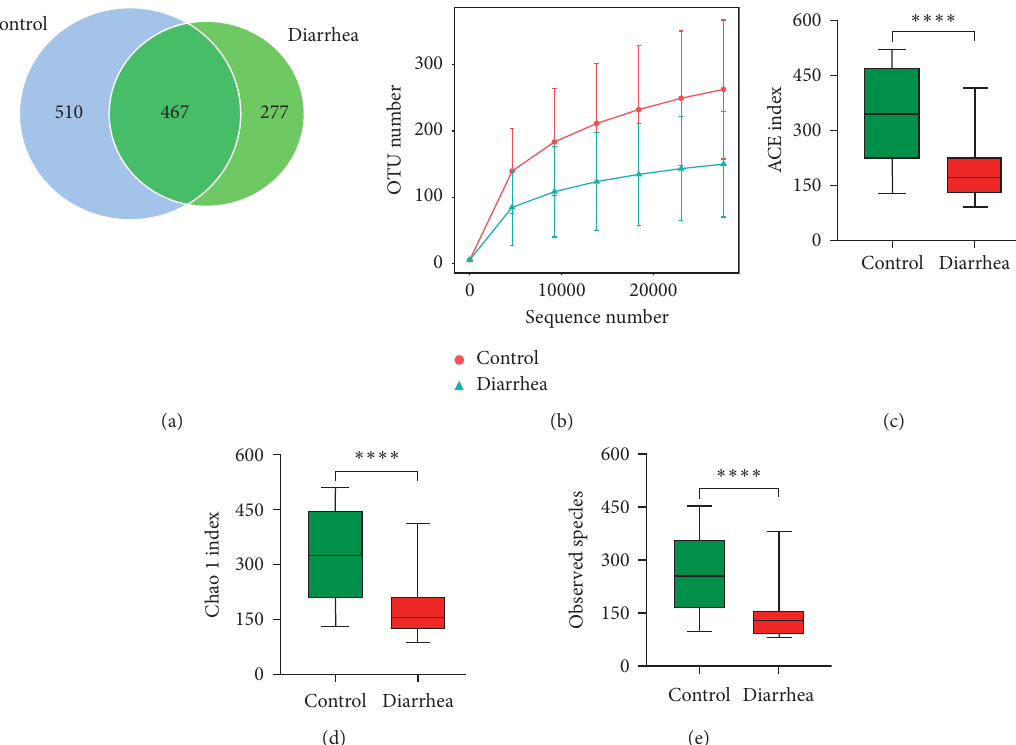
Figure 2: The alpha diversity of gut microbiota in healthy infants and diarrheic infants. (a) Venn diagram of OTUs in the two groups. (b) Observed species index in the two groups. (c–e) Comparing the alpha diversity indices (ACE, Chao 1, and observed species) based on the OTU